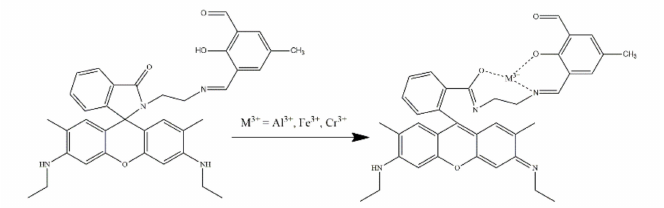
Figure 61. The proposed sensing mechanism of HL-CHO to Fe 3+ , Cr 3+ and Al 3+